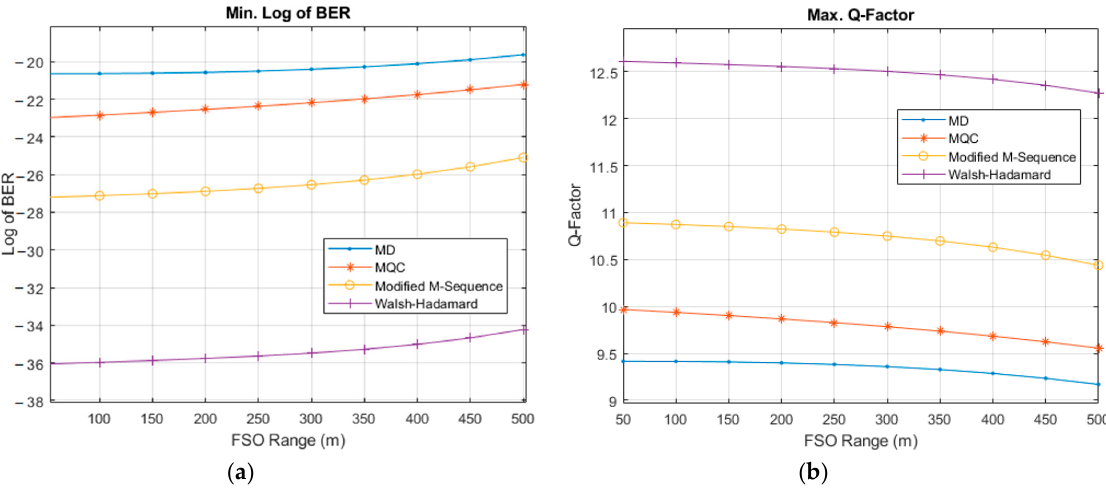
Figure 15. Performance of the system under medium turbulence condition: ( a ). min. log of BER; ( b ). max. Q ‐ factor.